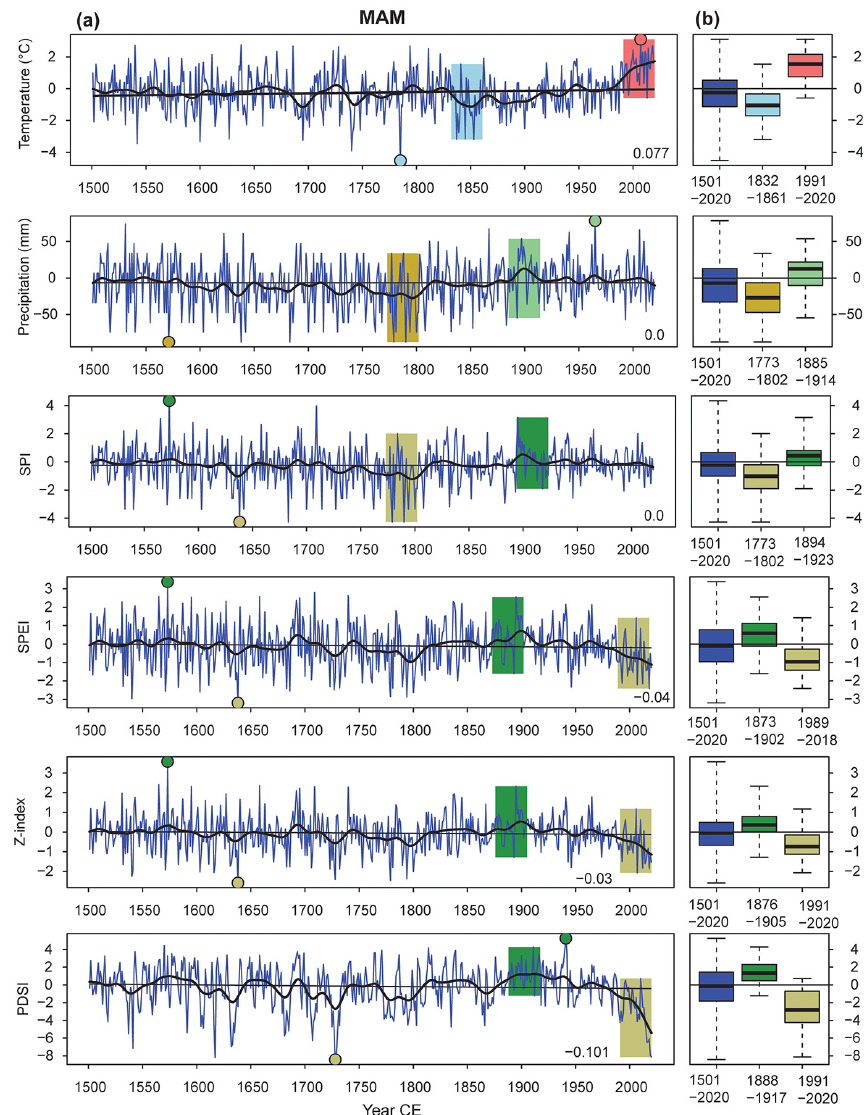
Figure 4. See text in Fig. 1;